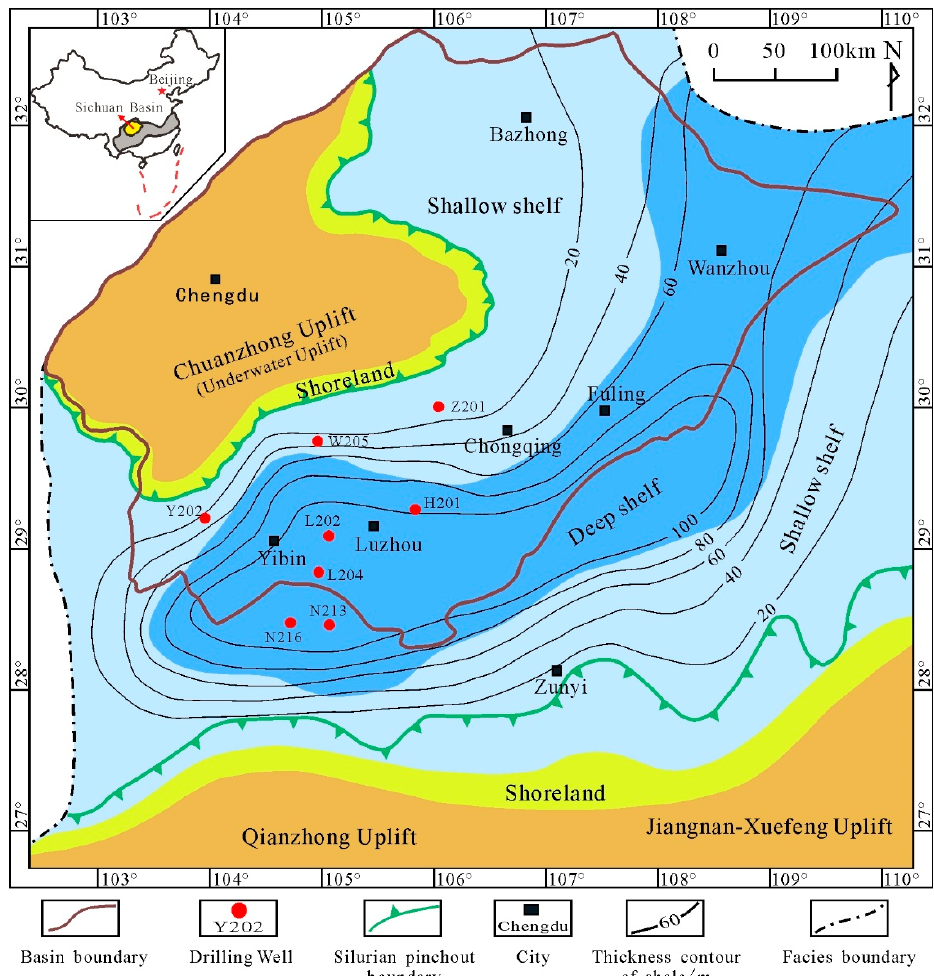
Figure 1. Location, sedimentary environment and isopach map of Silurian Longmaxi shales in the southern Sichuan (modified from Guo et al. [7] and Yang et al. [50]).